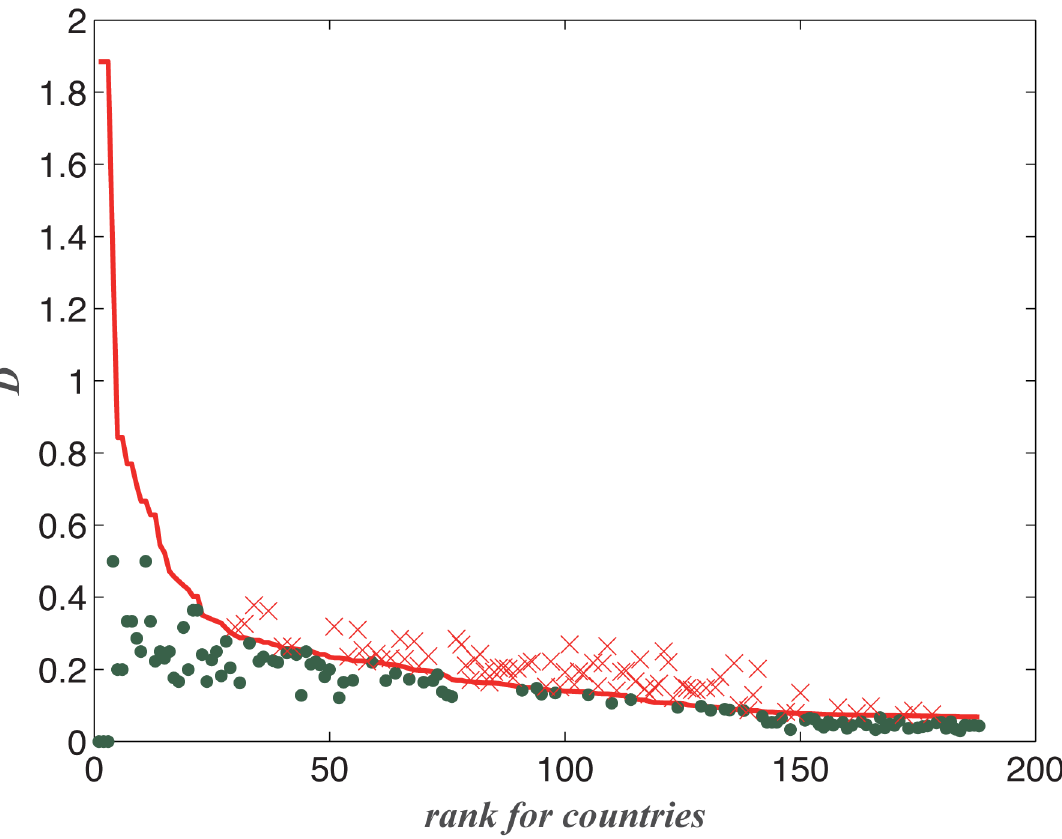
Fig 5. KS statistics for all countries. The red curve represents the critical KS statistics threshold of given sample size. The points above the curve marked by red crosses correspond the countries who are not passing the